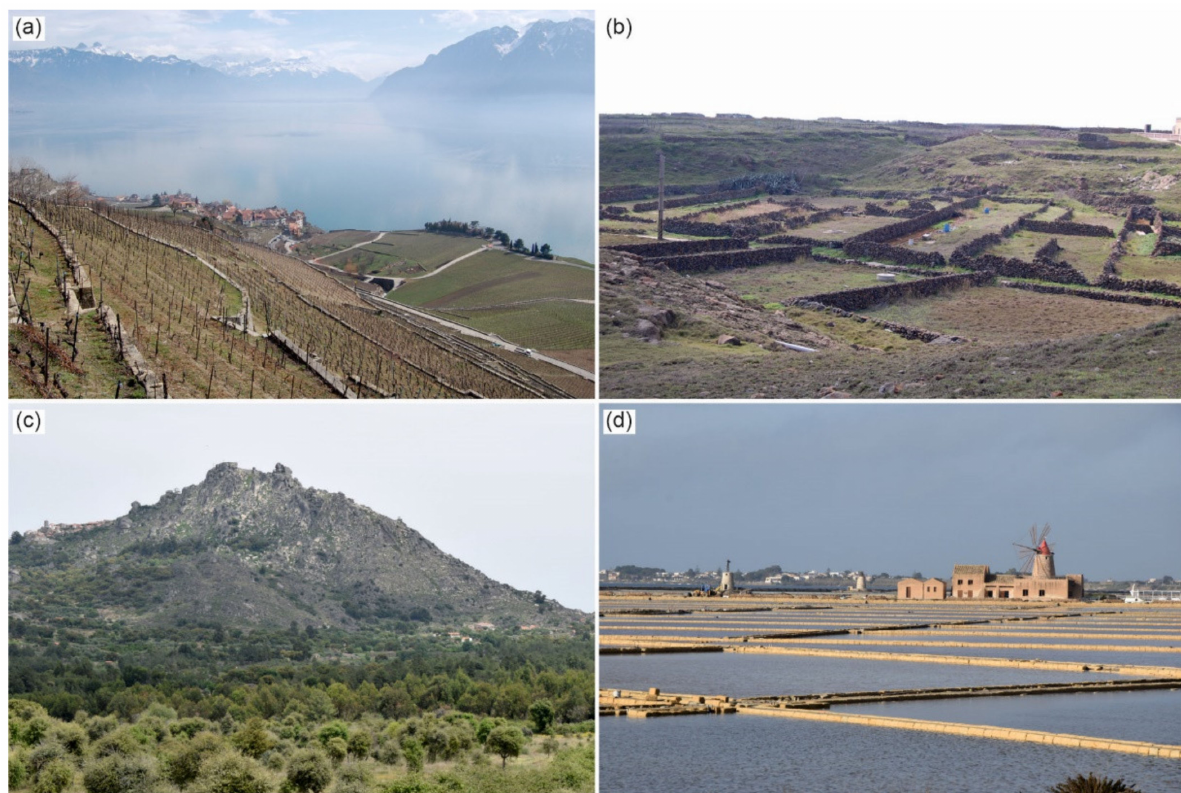
Figure 3. Cultural landscapes illustrating various connections with abiotic nature. ( a ) terraced slopes of Lavaux Vineyards in Switzerland, with the glacial trough of Lake Geneva in the background, ( b ) stone walls built of local basalt and pieces of corals are part of endangered cultural heritage of Penghu Islands, Taiwan, ( c ) granite inselberg of Monsanto, Portugal, with the village built almost exclusively from local granite (left) and castle ruins on the hilltop, ( d ) salt pans near Trapani, Sicily, Italy (all photographs by the